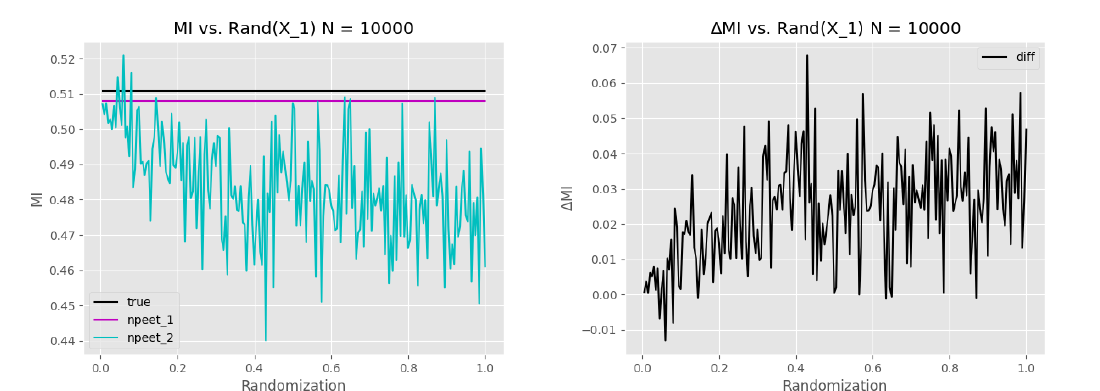
Figure 6. Comparison of true mutual information between the eight variables of a multivariate normal distribution where all correlation coefficients are equal to 1/2 (black line) and the value estimated from N = 10,000 samples before (npeet_1) and after (npeet_2) a randomization is applied to the set of redundant